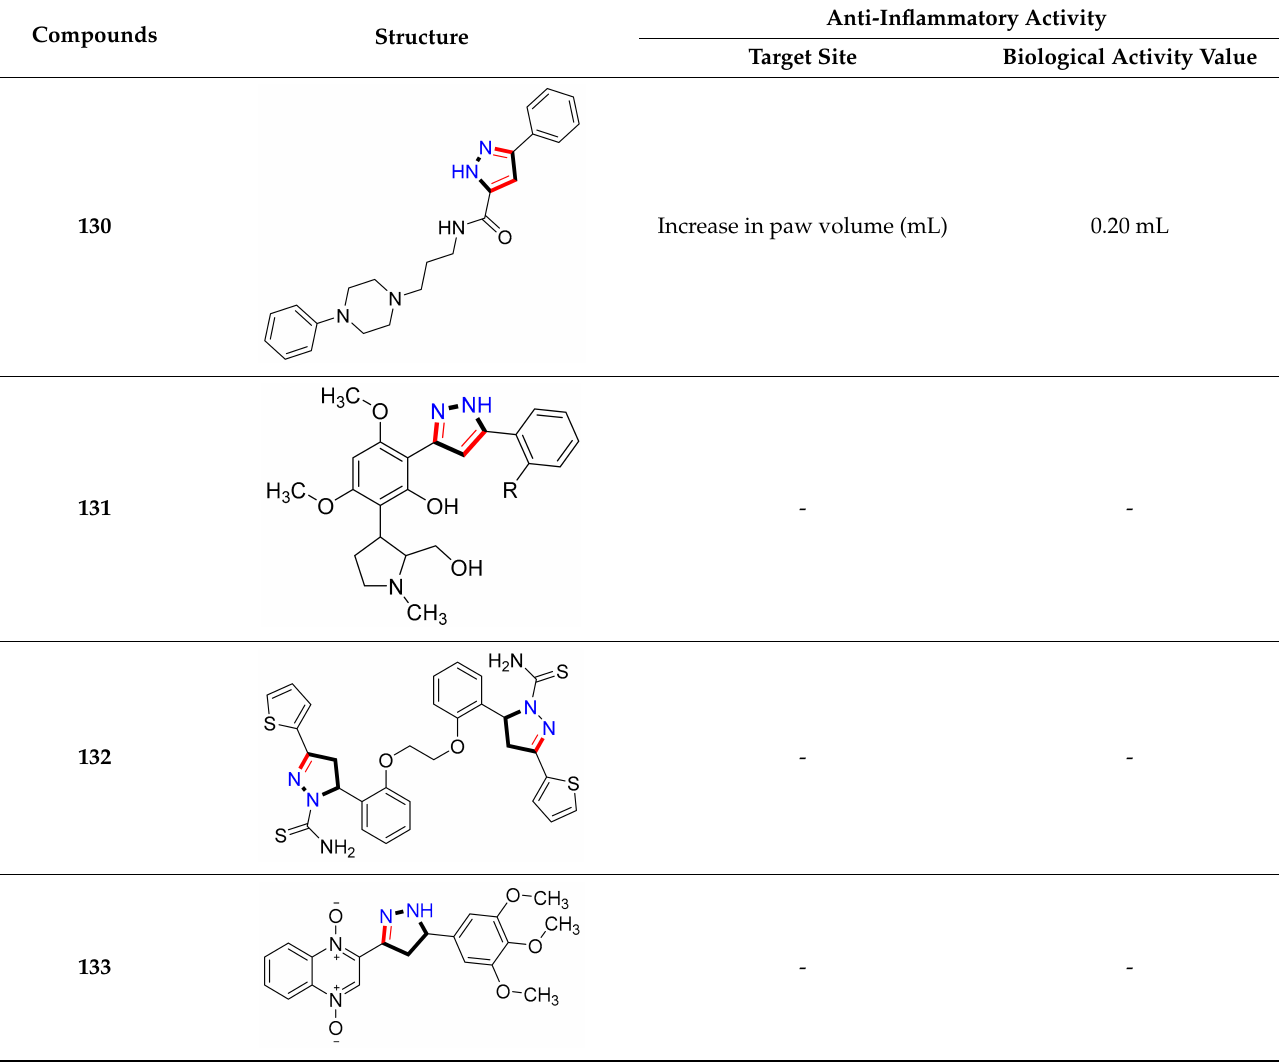
Table 10. Representative compound structures 130 to 146 and their anti-inflammatory